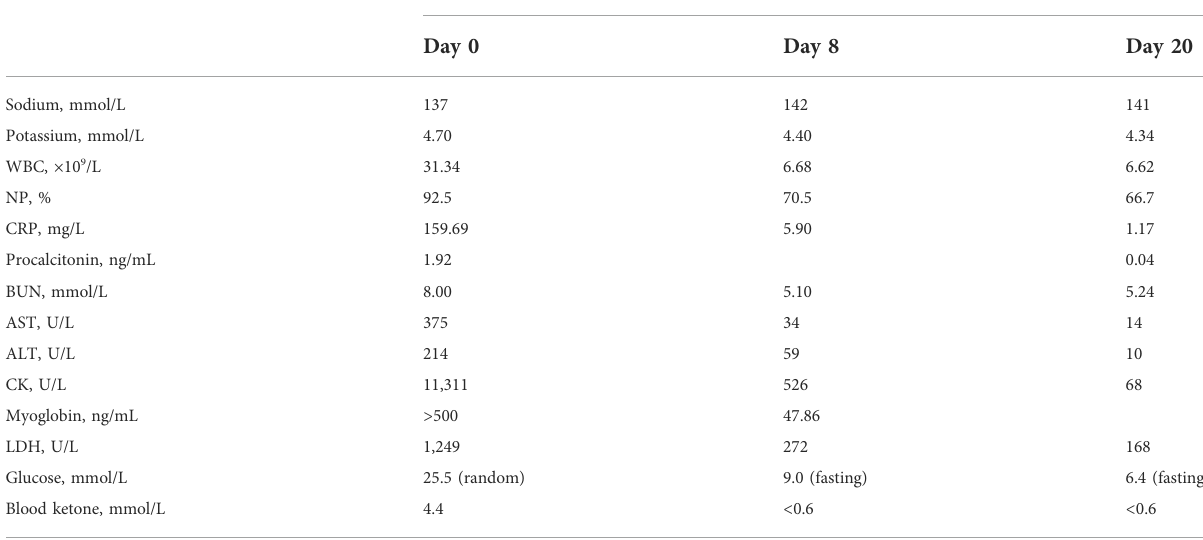
TABLE 1 Laboratory test results during patient